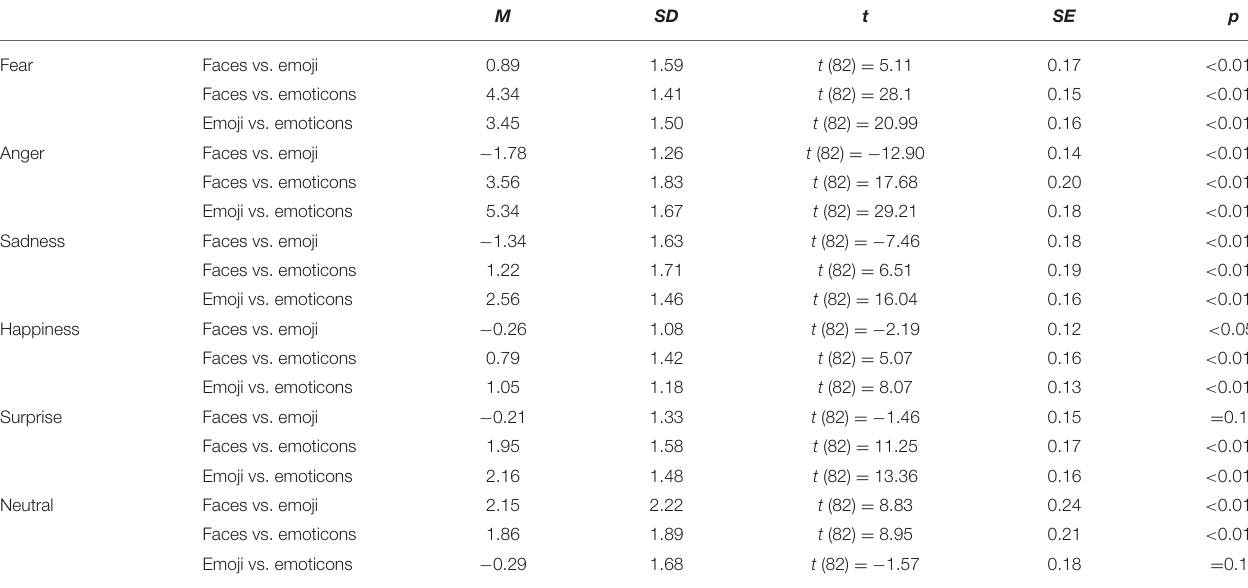
TABLE 2 | Results from post-hoc conducted t -test for emotionality for all discrete emotions paired with all stimulus categories.